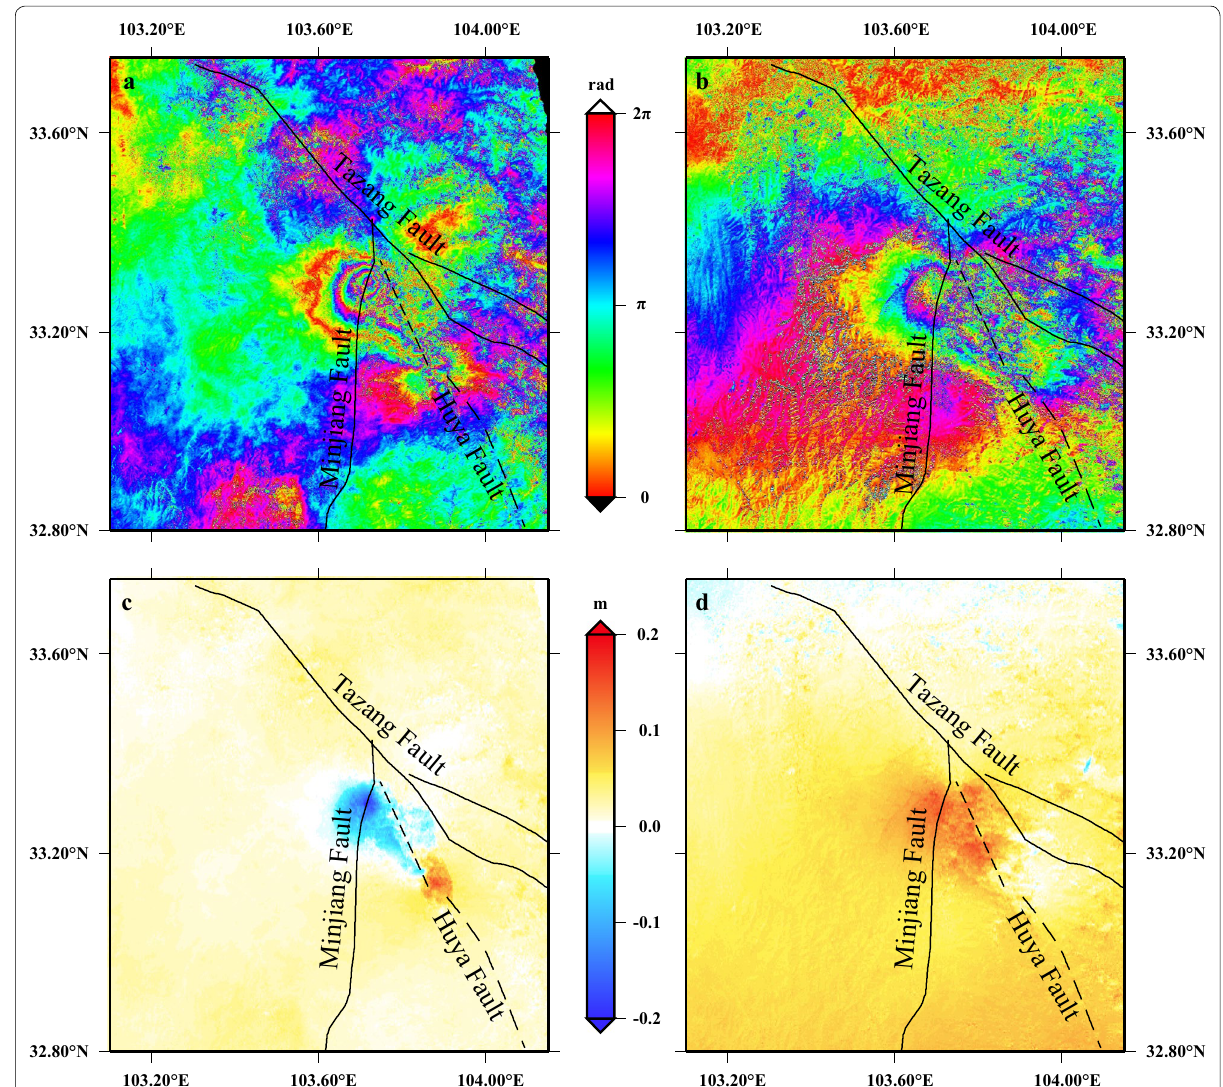
Fig. 2 Coseismic deformation of the Jiuzhaigou earthquake from InSAR. a , c Present the interferogram and LOS displacements along the ascending orbit. b , d Present the interferogram and LOS displacements along the descending